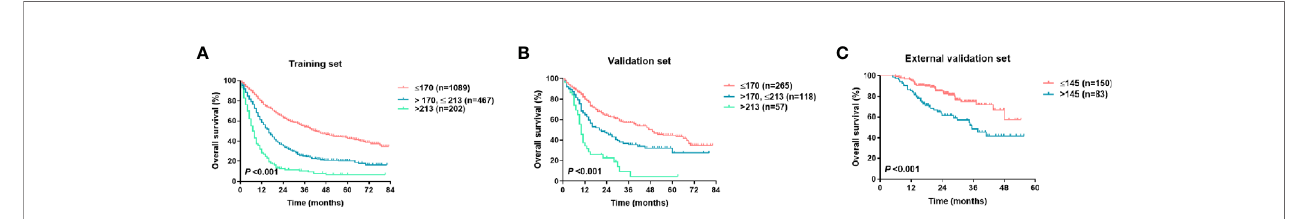
FIGURE 6 | Kaplan-Meier survival curves of the training set (A) , the validation set (B) , and the external validation (C) per nomogram